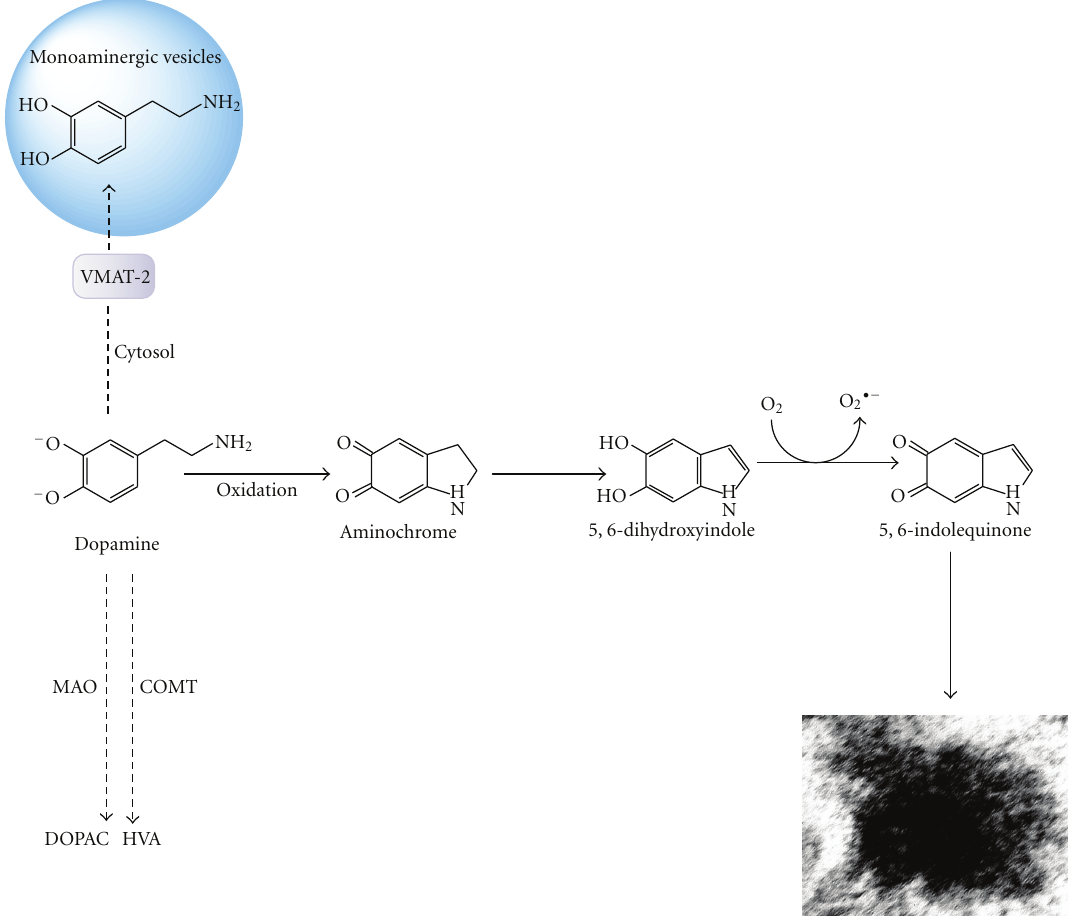
Figure 4: Neuromelanin formation. Dopamine is oxidized to aminochrome, which tautomerizes to 5,6-indolequinone and undergoes polymerization to form the dark pigment